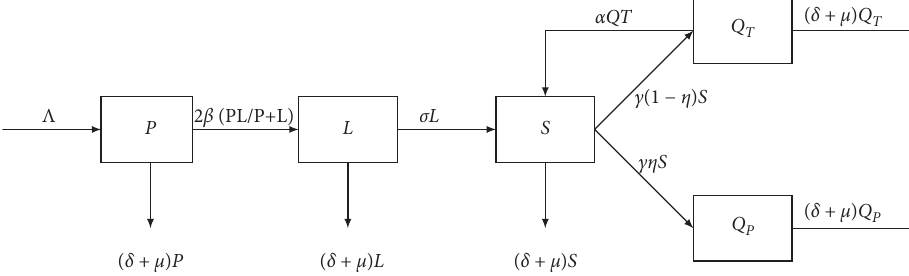
Figure 1: The flowchart of the PLSQ